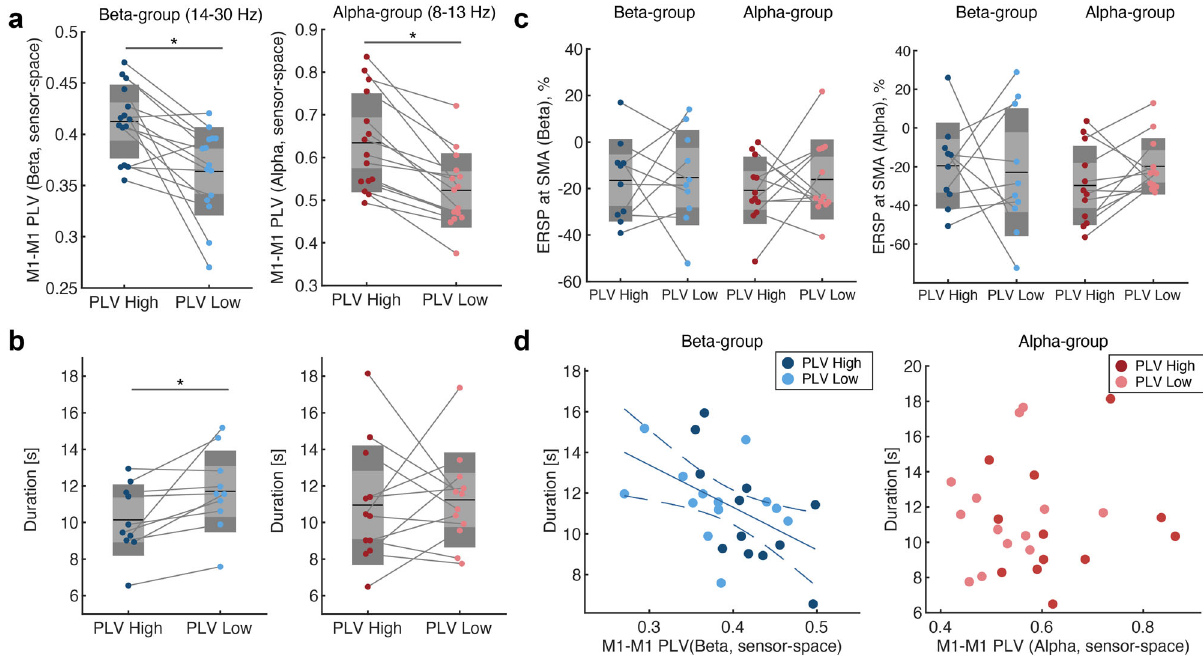
Fig. 2 Performance improvement of anti-phase bimanual coordination using brain state-dependent movement initiation paradigm. a Comparison of phase-locking values (PLVs) of bilateral primary motor cortices (M1) between two conditions. Groups based on M1-M1 PLVs in both beta- and alpha-bands exhibited signi fi cant differences in high and low conditions (paired t-test, * p < 0.05, exact values in the main text). b Comparison of duration of anti-phase bimanual tapping between the two conditions. The group based on M1-M1 PLV in the beta-band exhibited signi fi cant differences between high and low conditions (paired t -test, * p < 0.05, exact values in the main text). c Comparison of pre-movement ERSP at SMA. Left : ERSP in the beta-band (a mixed two- way repeated measures ANOVA, statistical values in the main text). Right : ERSP in the alpha-band (a mixed two-way repeated measures ANOVA, statistical values in the main text). d Correlation analysis between M1-M1 PLV and duration (repeated measures correlation test, beta: r = − 0.65, p = 0.016; alpha: r = − 0.29, p = 0.33). Solid and dotted lines indicate linear regression and a 95% con fi dence interval, ^ β = − ^ β = − ERSP: 0.468, p = 0.002, M1-M1 PLV: 4.15, p = 0.61;